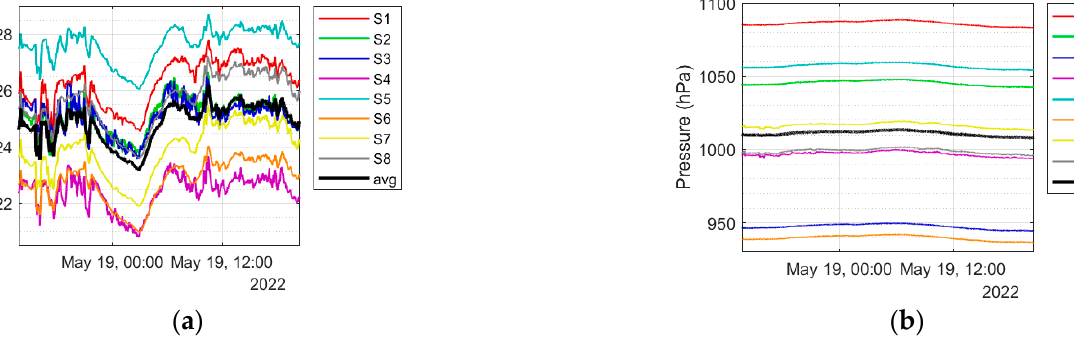
Figure 2. Measurements carried out by eight BMP280 sensors: ( a ) temperature; ( b ) pressure.